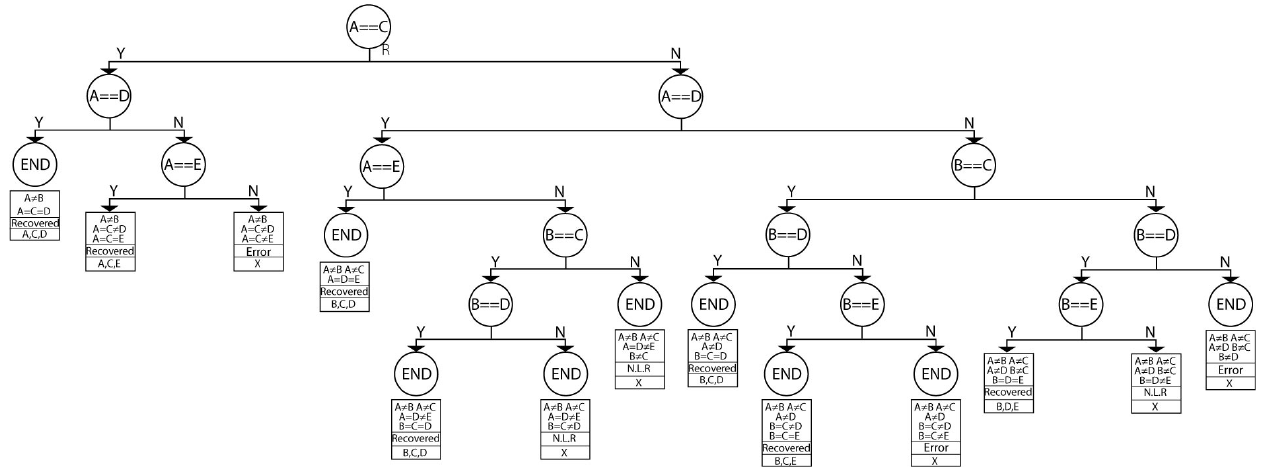
Figure 6. Sub-tree R for evaluating the remaining comparators according to branch Y from tree P